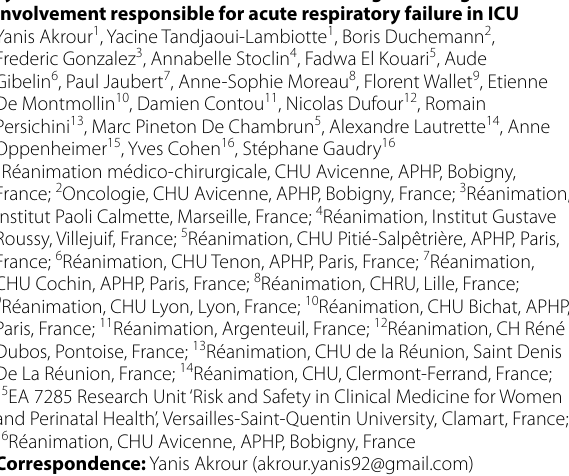
Fig. 1 Swimmer plots of patients admitted in the intensive care unit for an immune related adverse event F‑089 Tyrosin kinase inhibitor: an effective tool against lung cancer involvement responsible for acute respiratory failure in ICU